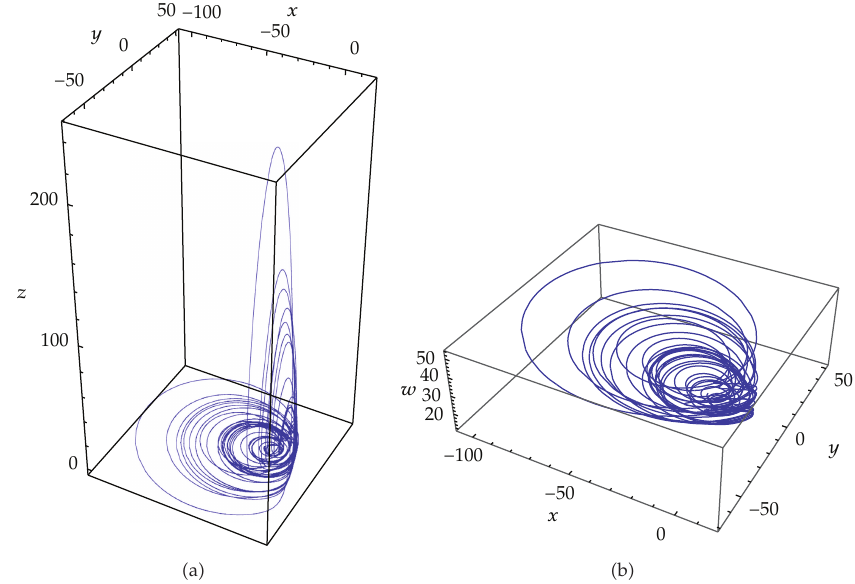
Figure 5: Phase plot of hyperchaotic attractor in the x - y - z and x - y - w spaces, with a (cid:8) 0 . 25, b (cid:8) 3, c (cid:8) 0 . 5, d (cid:8) 0 . 05, and α